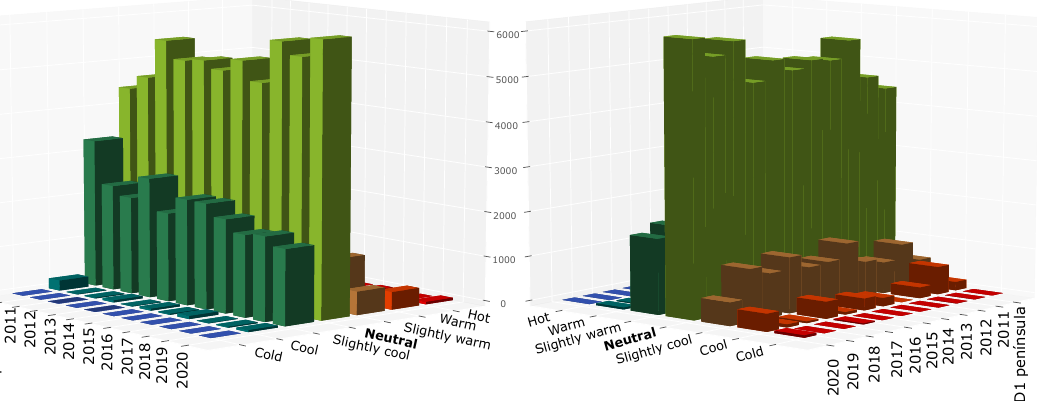
Figure 6. Comfort results taking into account the CTE-2019 standard and the Pamplona actual meteorological years